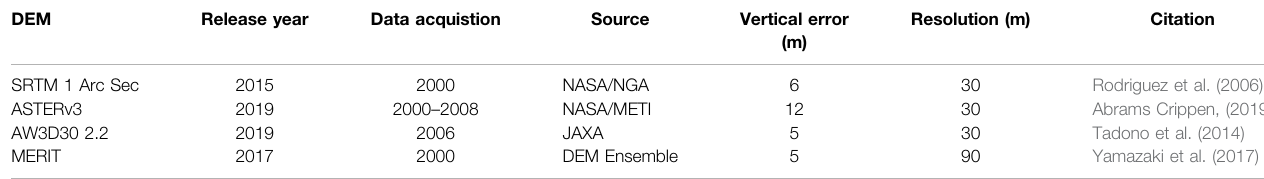
TABLE 1 | Global DEMs with their respective sources and